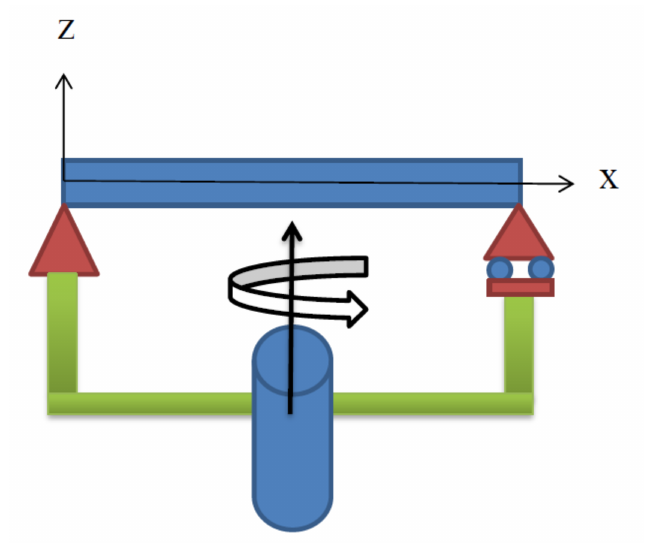
Figure 1. Simply-supported micro-beam rotating around z